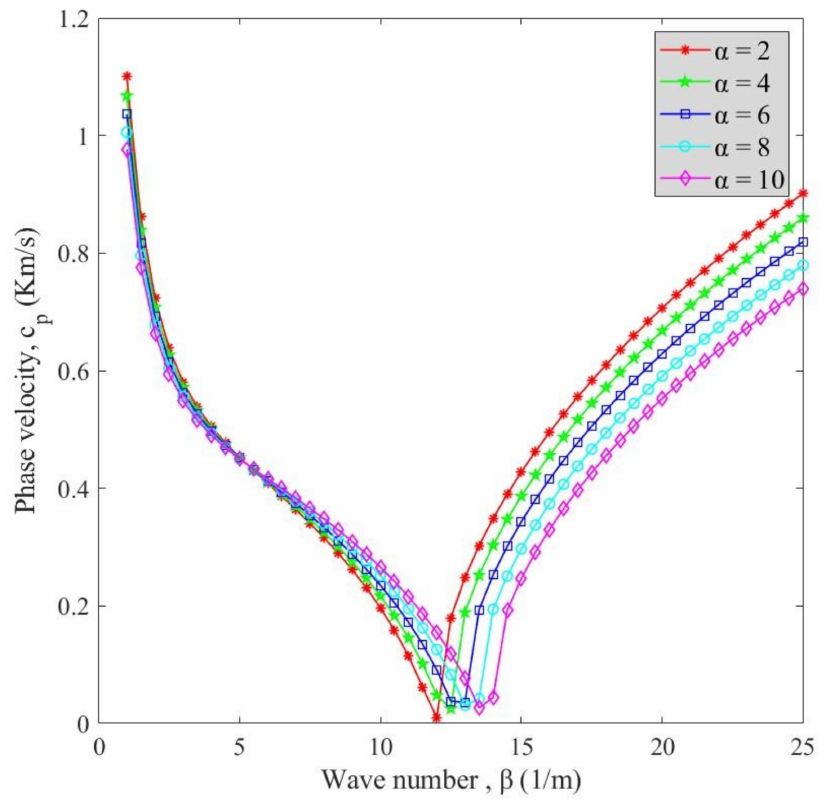
Figure 7. Variation of phase velocity versus wave number for different agglomeration degrees ( α